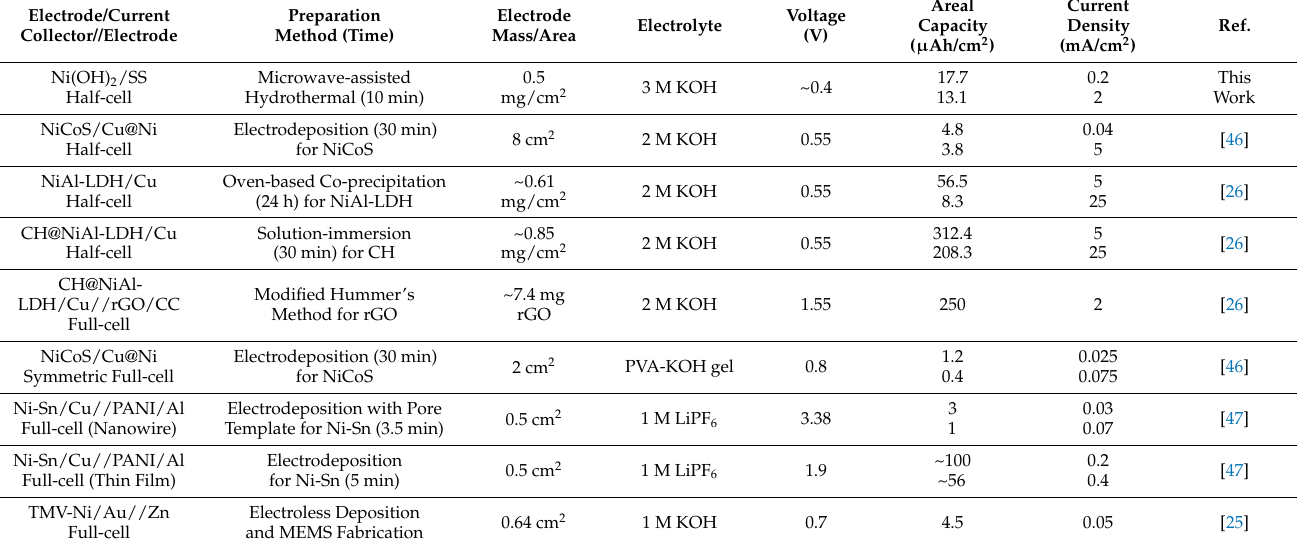
Table 4. Comparative areal capacity and testing conditions of our optimized electrode and some reported Ni-based